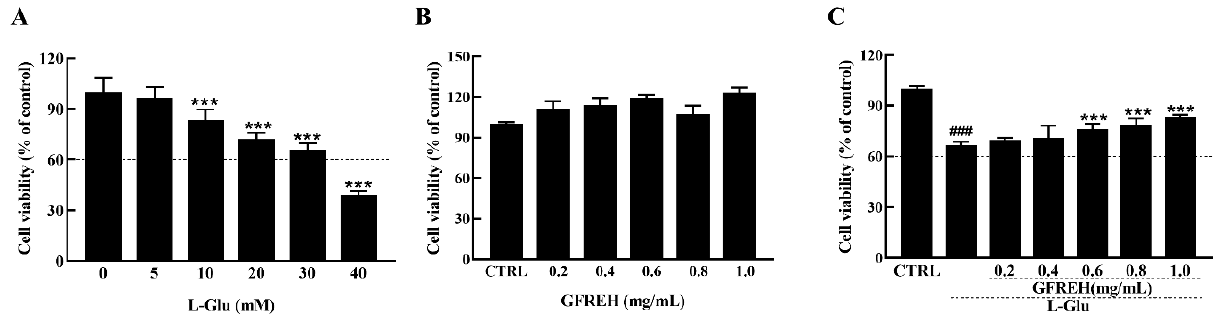
Figure 3. ( A ) The effect of L-Glu on apoptosis of SH-SY5Y cells, (n = 6). ( B ) GFREH treatment alone for 24 h caused no decrease in the viability of SH-SY5Y cells, (n = 6). ( C ) GFREH pretreatment for 4 h and incubation with L-Glu for an additional 24 h improved cell viability, (n = 6). The data are presented as the mean value ± SD. ### p < 0.001 vs. CTRL, *** p < 0.001 vs. L-Glu-treated cells. CTRL: untreated cells, L-Glu, cells treated with L-Glu.